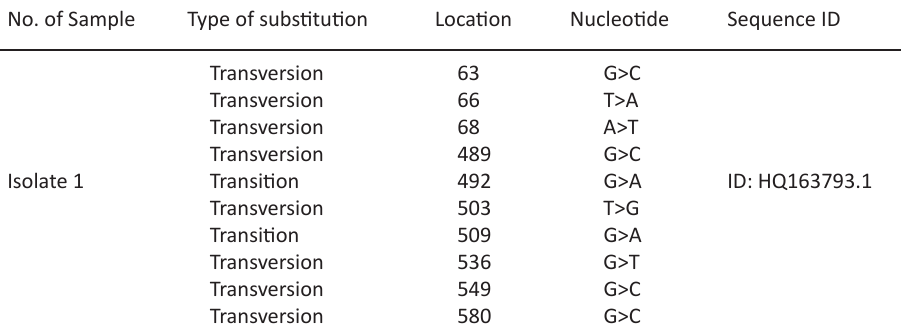
Table 1. Represent type of polymorphism of 16S rRNAgene from E. coli isolate No. of Sample